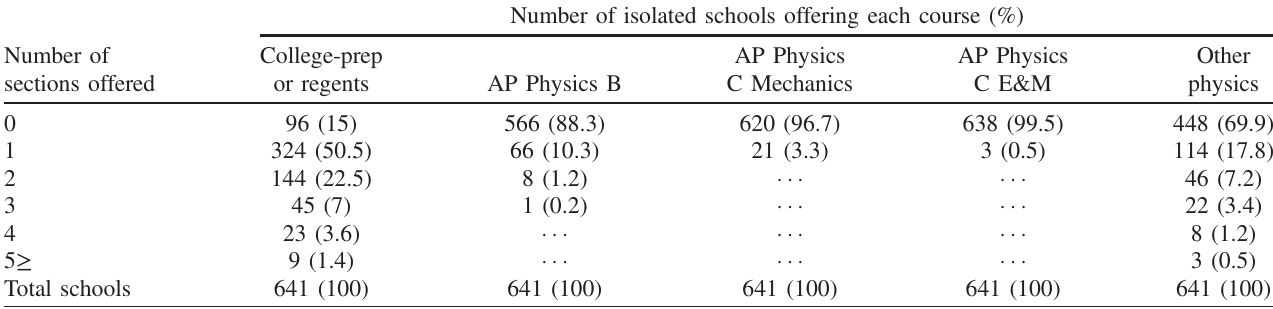
TABLE V. Prevalence of physics courses in schools of isolated physics teachers. Number of isolated schools offering each course (%)